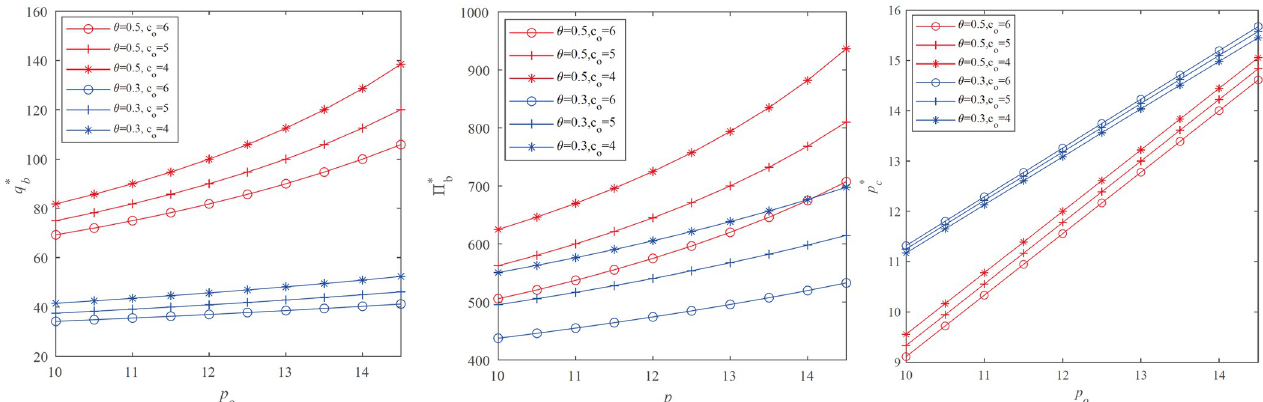
Fig 4. Impact of full price on the retailer’s optimal decision.